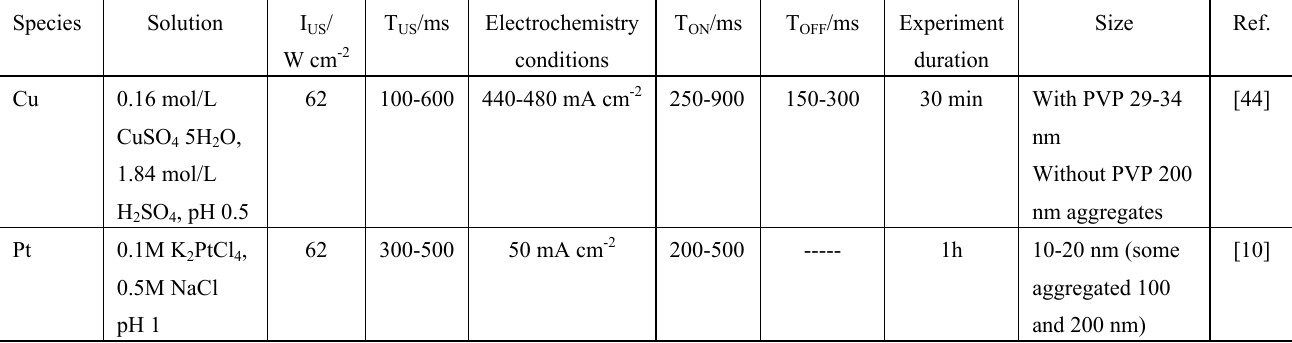
Table 1. Experimental conditions for the pulsed sonoelectrochemistry synthesis for different nanomaterials using a 20kHz titanium horn as working